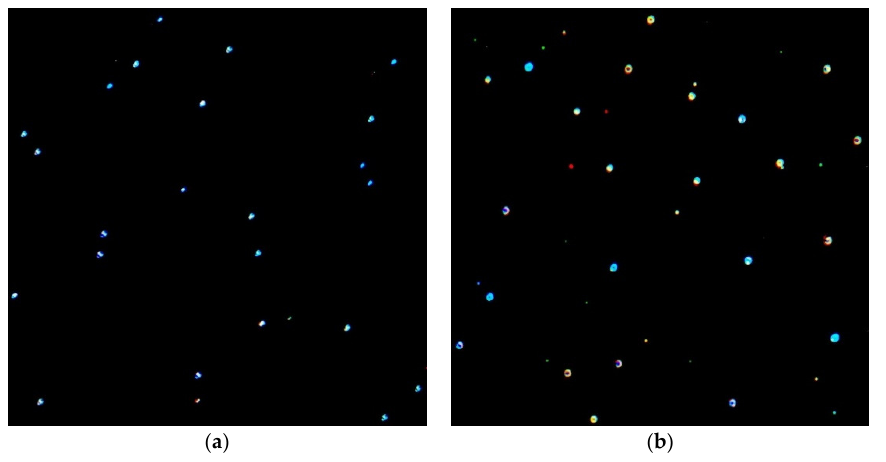
Figure 11. Micrographs obtained by dark-field optical microscopy that show the light scattered by AuNPs for P 0.12 sample: ( a ) without glycerol (0%) and ( b ) with a glycerol concentration of 50%. The magnification was 30 ×. Different-colored AuNPs highlight the fact that they had different geometries.